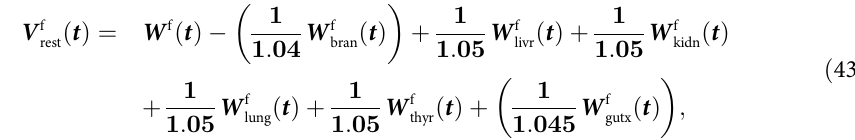
PLOS ONE | https://doi.org/10.1371/journal.pone.0215906 May 2,